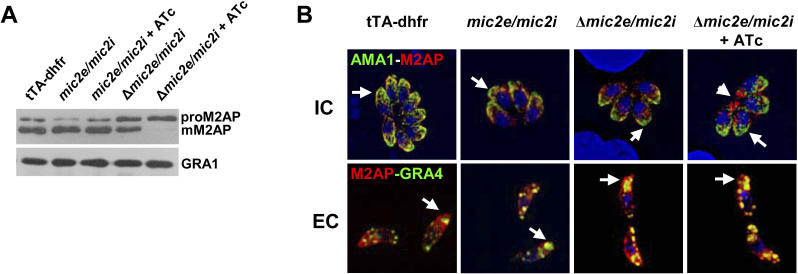
Proteolytic Maturation and Localization of M2AP Is Dependent on Expression of MIC2(A) Western blot of whole cell lysates showing steady-state expression levels. Blots were probed as indicated. Proform M2AP (proM2AP); mature M2AP (mM2AP).(B) Expression and localization of M2AP in intracellular (IC) and extracellular (EC) parasites. Top panels: dual staining of M2AP (red) with AMA1 (green) in IC parasites showing mislocalization of M2AP in the PV of Δmic2e/mic2i + ATc parasites. Bottom panels: immunostaining of M2AP (red) and GRA4 (green) in EC parasites shows a progressive increase in M2AP expression in dense granules, particularly in Δmic2e/mic2i + ATc parasites. Arrows indicate the apical poles of parasites and an arrowhead indicates the PV.